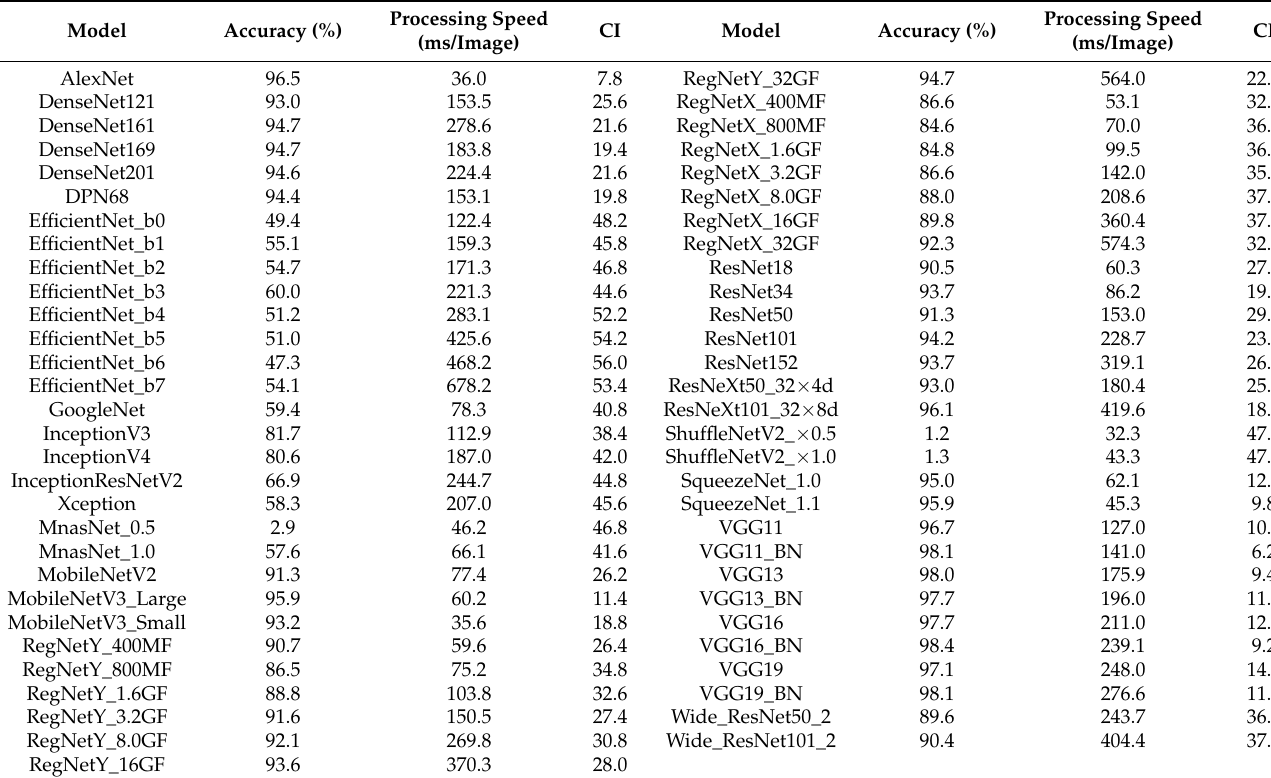
Table 3. Model performance parameters (testing accuracy, processing speed, and comprehensive index (Equation (3))) of individual beef cattle classification. The outperformed models for each parameter were highlighted in bold